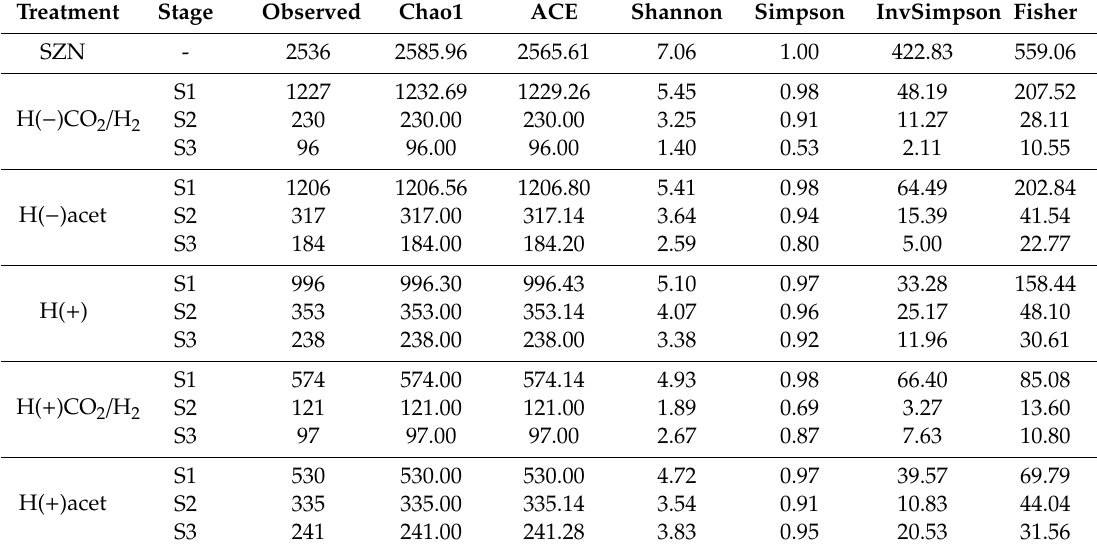
Table 4. Biodiversity indices of the experimental treatments.